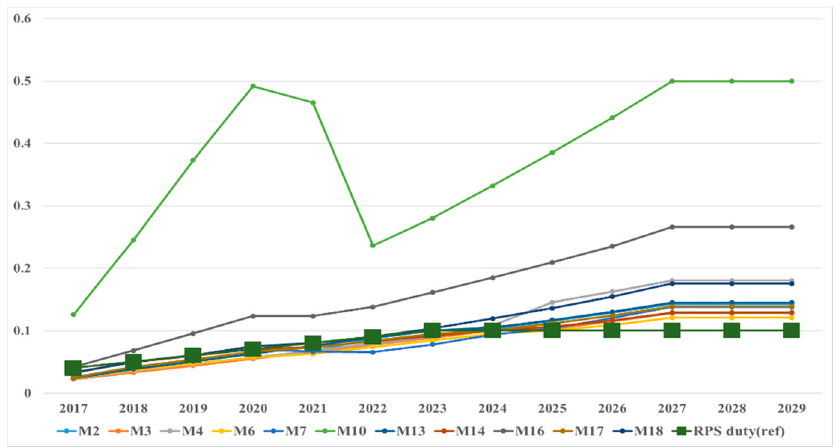
Figure 8. RPS ratio changes of each power producer in the IF segment.